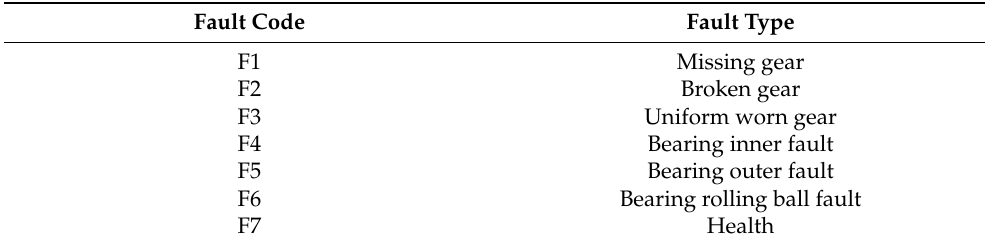
Table 5. Design of the experimental conditions.